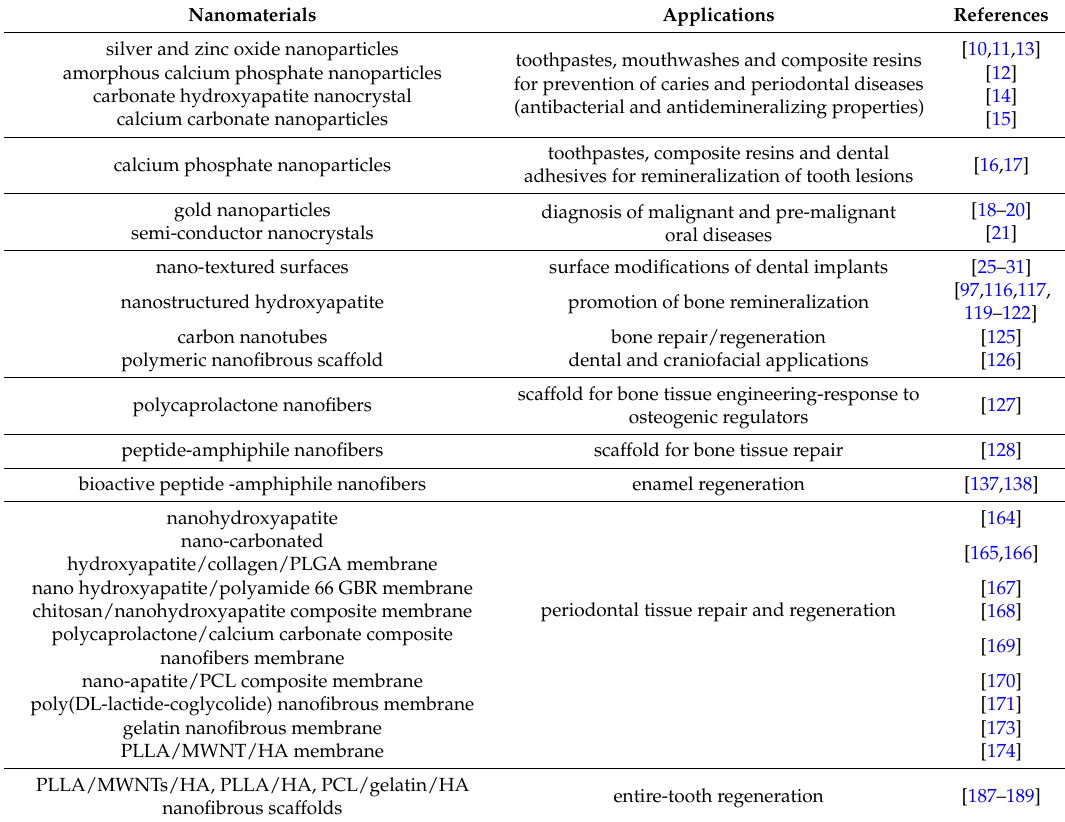
Table 2. Summary of various nanomaterials used for tissue engineering in